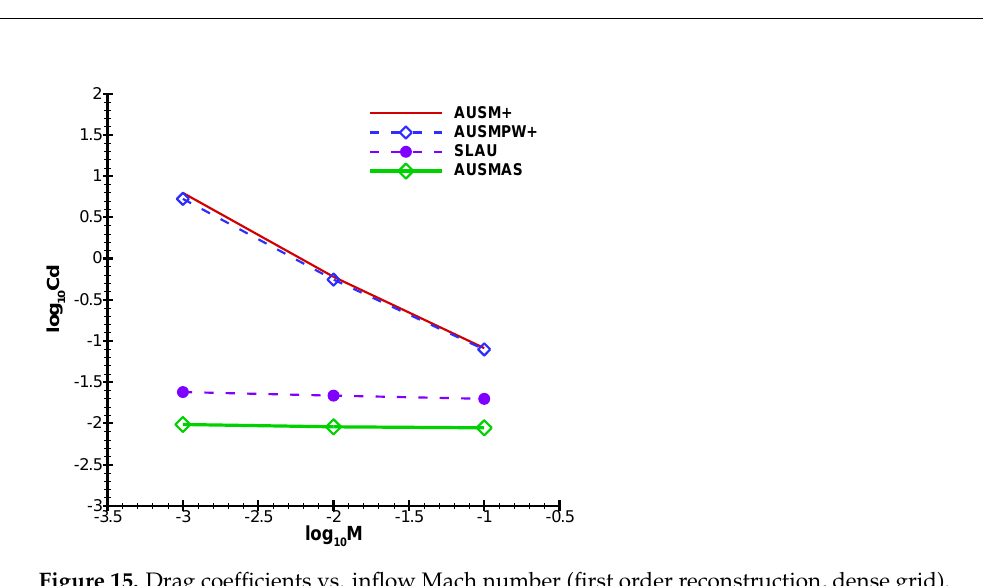
Figure 15. Drag coefficients vs. inflow Mach number (first order reconstruction, dense grid).